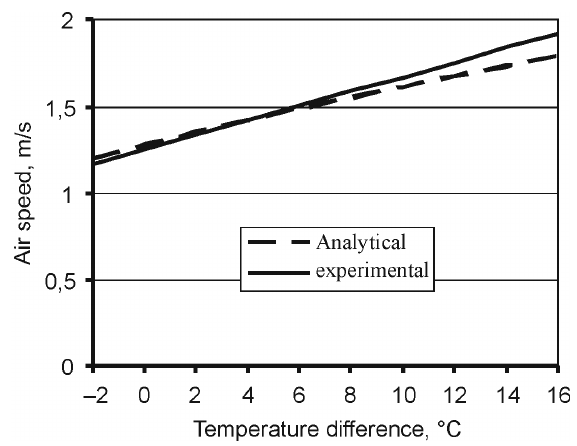
Fig. 4. Comparison of experimental (equation 16) and analytical (equation 13) data of air speed in outlet opening for various indoor-outdoor temperature differencies (dif- ference between experimental and analytical values does not exceed